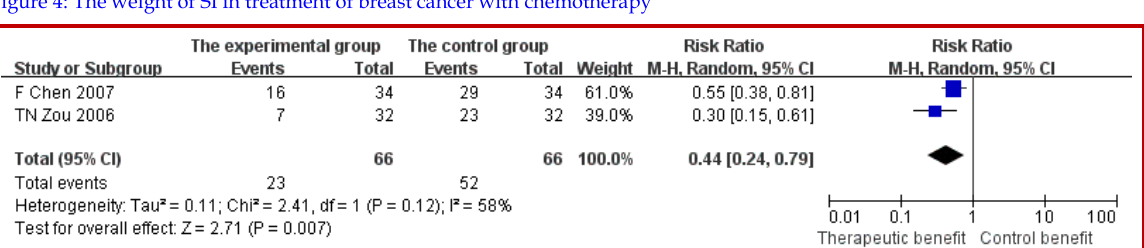
Figure 4: The weight of SI in treatment of breast cancer with chemotherapy